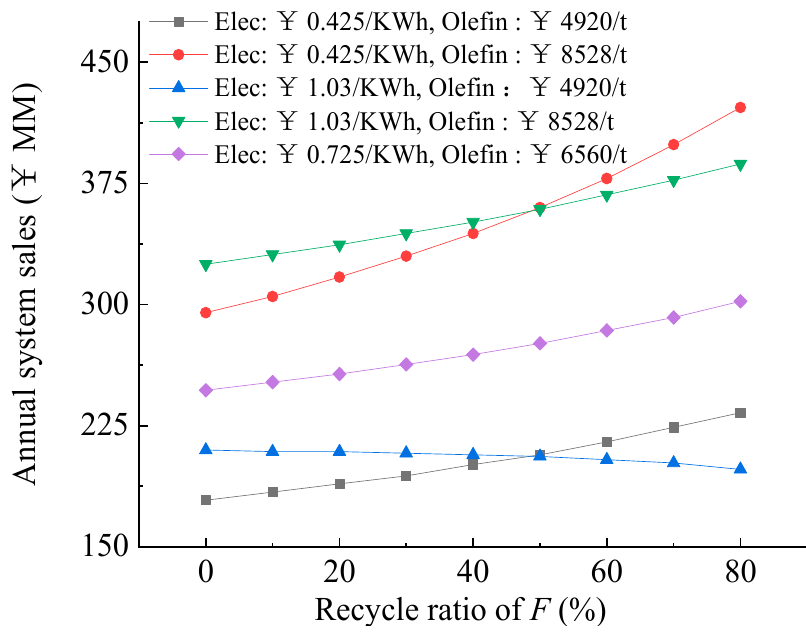
Figure 6. Relationship between the recycle ratio of synthesis tail gas and annual system sales. The overall system annual sales for the base case are ¥ 247 MM/a, which increases to ¥ 302 MM/a at the F value of 80%. With the increase of the F value and overall exergy efficiency, the tendency of system sales keeps increasing, except for the scenario with high electricity price and low olefin prices. It could attribute to the increasing electricity demand at high F values. The increase of light olefin sales by its high yield is somehow offset by external electricity cost. The remarkable increase of annual sales is found for the scenario with low electricity price and high olefin price. The maximum sales are ¥ 422 MM/a at the F value of 80% since the contribution of olefin sales plays the dominant